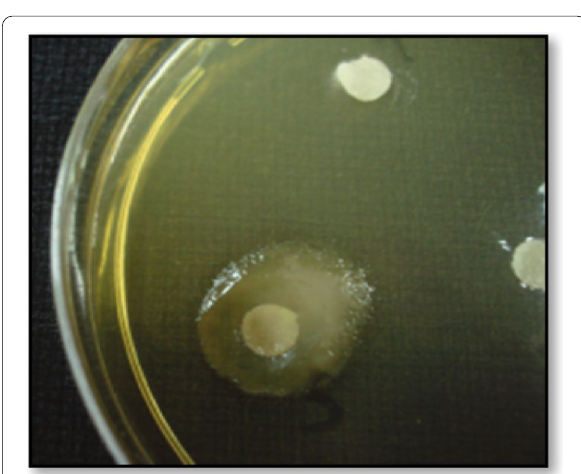
Fig. 2 Mucoid colony of an exopolysaccharide‑producing microbe on solid media